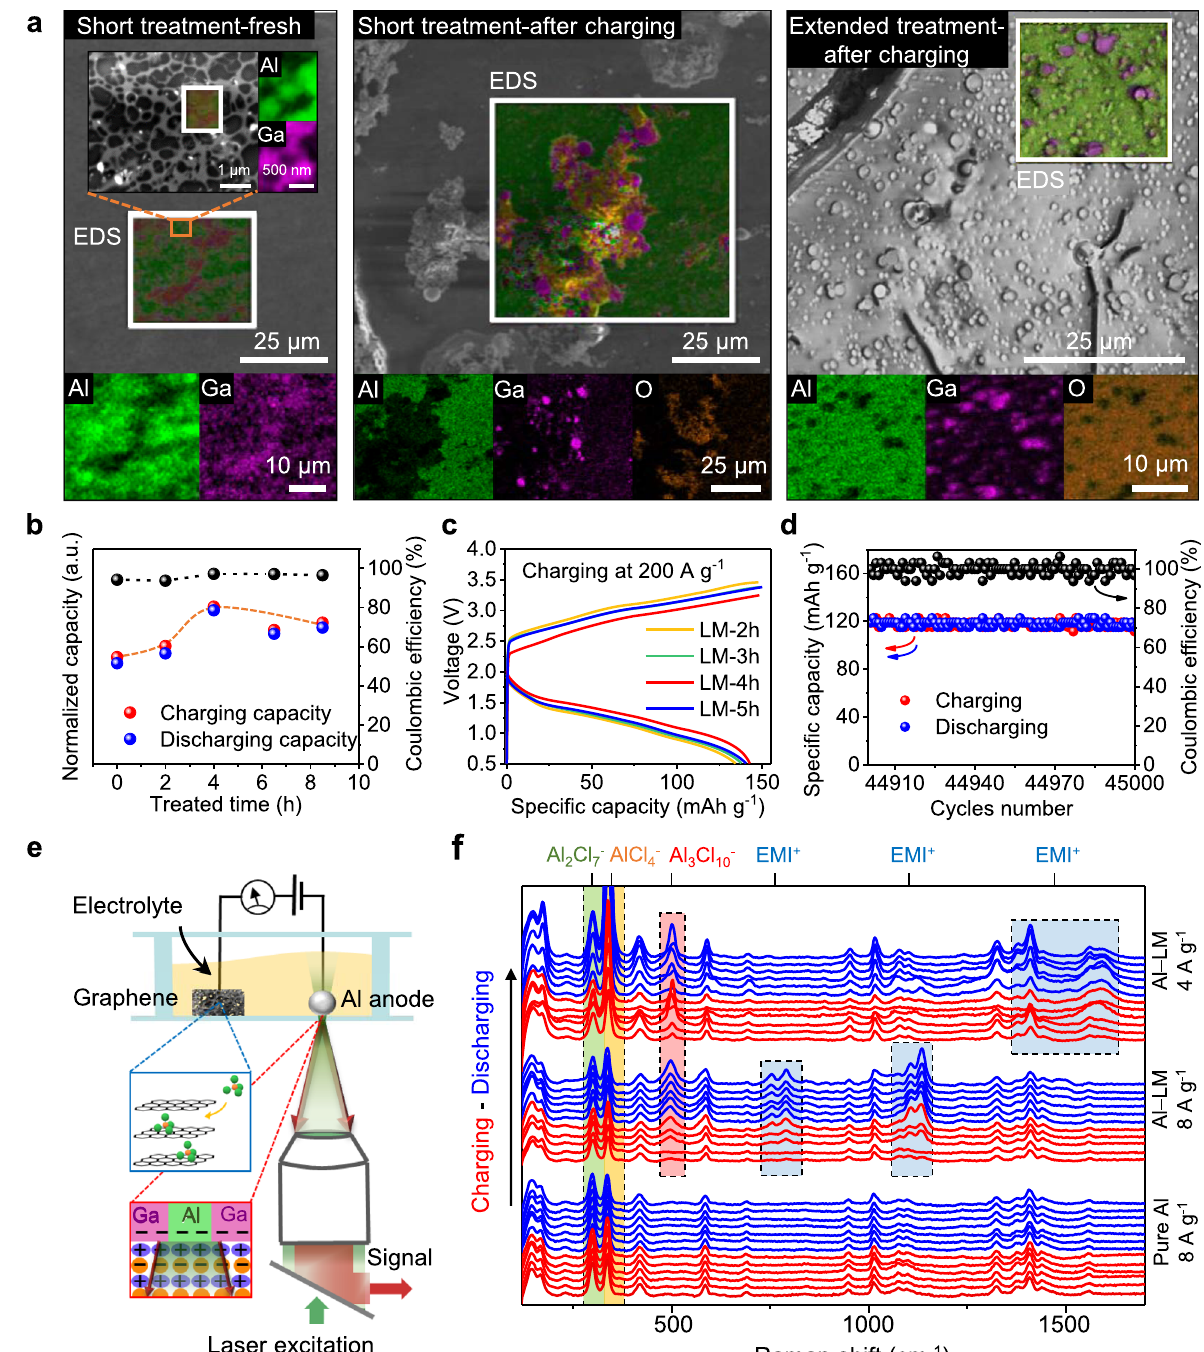
Fig. 3 Probing the role of the active anode. a SEM images and elemental mapping (EDS) of gallium distribution on anode. Before charging, liquid metal forms a spread-out network on Al. After charging, part of the liquid metal wraps up as spheres next to those newly grown aluminum sites. b The effect of liquid metal treatment time on capacity (charging and discharging current density of 20 A g − 1 and cut-off voltage of 2.45 V). c Galvanostatic charge and discharge curves. Graphene cathode has a mass of 0.026 mg and density of 0.16 mg cm − 2 . Note the optimal time (4 h) has the lowest saturation voltage and maximum capacity ( i c = 200 A g − 1 ). d Stability test of our Al-ion batteries using active anode over 45,000 cycles (same charging and discharging current density of 40 A g − 1 , cut-off voltage of 2.45 V). e Raman setup to study reaction on the active anode. f Time series of Raman spectra for one full cycle of charging and discharging at the interface of anode ( i c = i dc ). Al 2 Cl 7 − , 299 cm − 1 (green zone); AlCl 4 − , 338 cm − 1 (yellow zone); Al 3 Cl 10 - , 500 cm − 1 (red zone); and EMI + , 753, 790, 1135, 1410, 1590 cm − 1 (blue dendrites from a charged anode were different: a brief exposure in channels of Ga inside polycrystalline Al grains. When this piece air made them oxide rich (seconds before sealing the SEM of anode was charged in a battery, dendrites were generated, with chamber), while surrounding fl at domains were not much affec- Ga-rich (purple) spherical particles lying next to the roots. While ted by this exposure. Once the anode treatment was extended to we did not detect signals from oxides on a freshly treated anode,